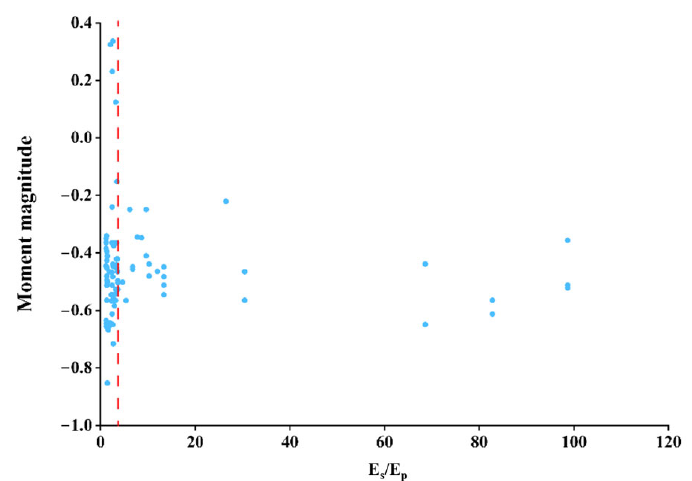
Figure 10. E s /E p of microseismic energy.